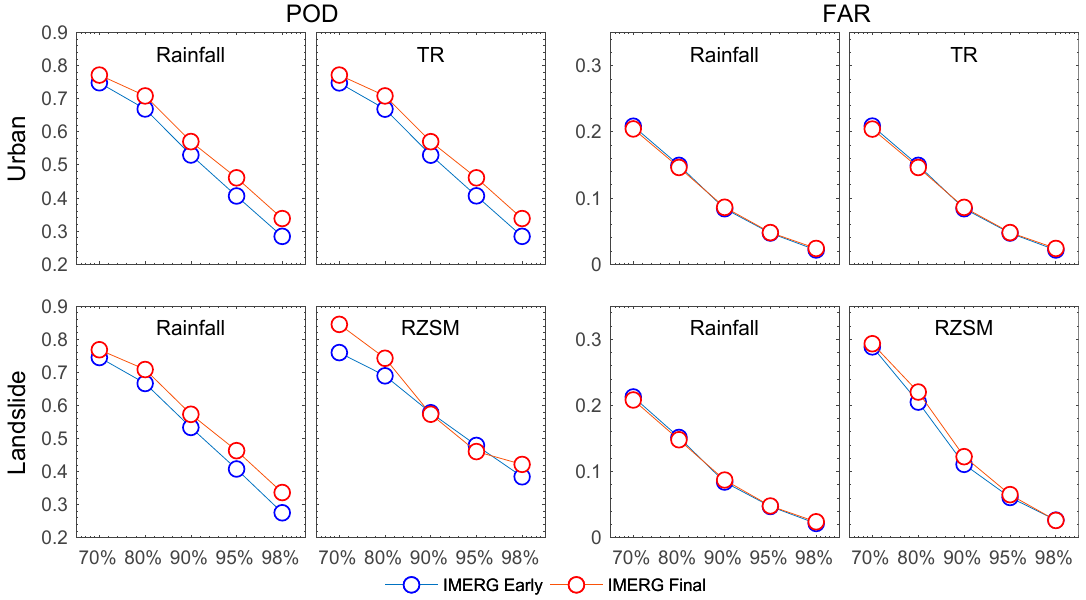
Figure 9. Median POD and FAR for rainfall, rootzone soil moisture (RZSM) and total runoff (TR) rates derived from IMERG-E and IMERG-F experiments at percentile thresholds of ≥ 70%, ≥ 80%, ≥ 90%, ≥ 95% and ≥ 98% over the urban and landslide-prone areas.